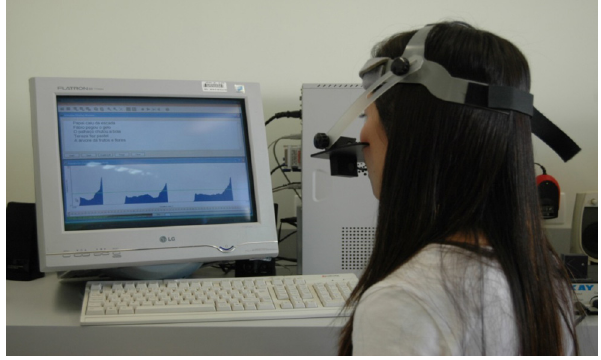
Distribution in percentage of the classification of recorded sample judgement by judges in the four-point